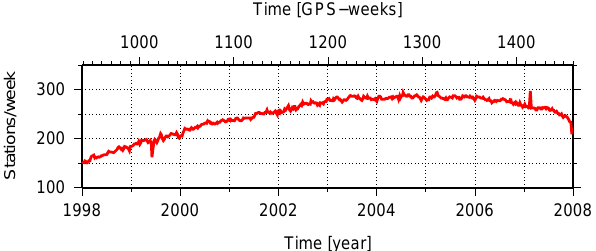
Fig. 3. Weekly overall mean of station coordinate repeatabilities for north (N), east (E) and up (U) components.